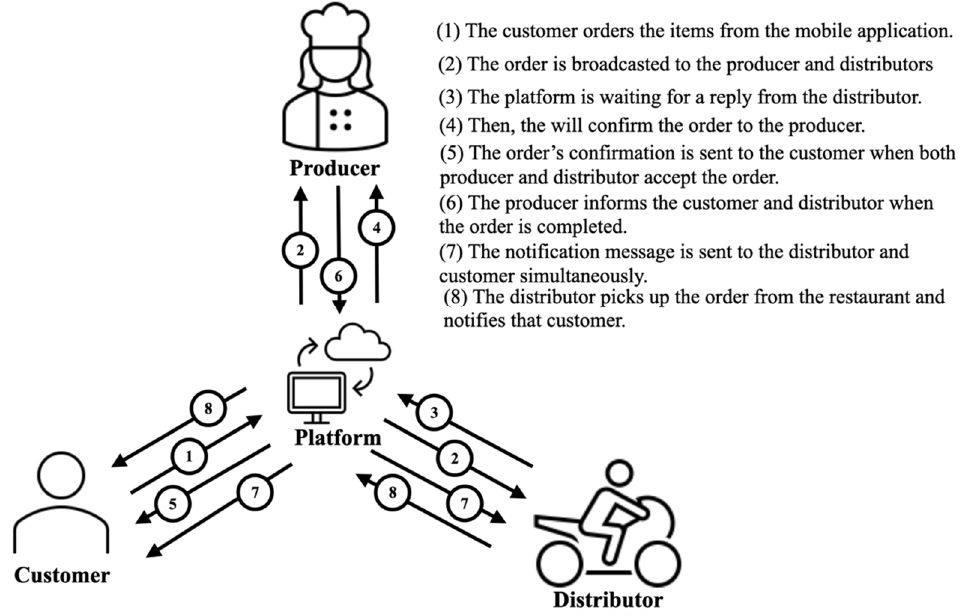
Figure 1. The workflow of a food delivery platform is the use case of this research. The producer is a restaurant, while the customer is a client. The distributor for the food delivery normally is a rider.